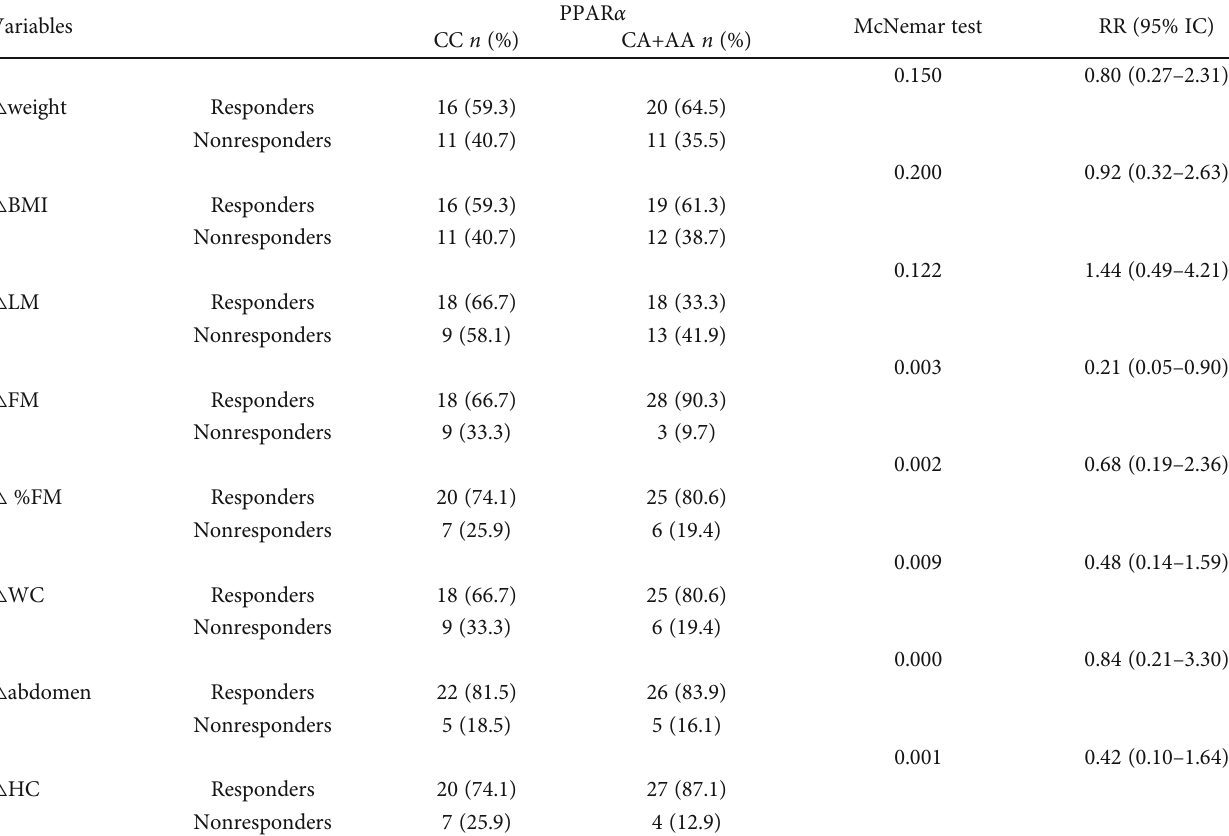
Table 4: Distribution test between the polymorphism in Intron 7 G/C (rs 4253778) of the PPAR α gene and responders and nonresponders to weight loss training program.